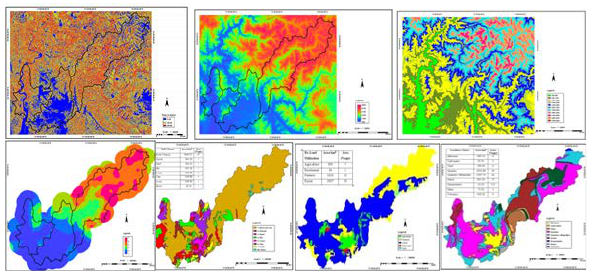
Figure 3. Input data layers